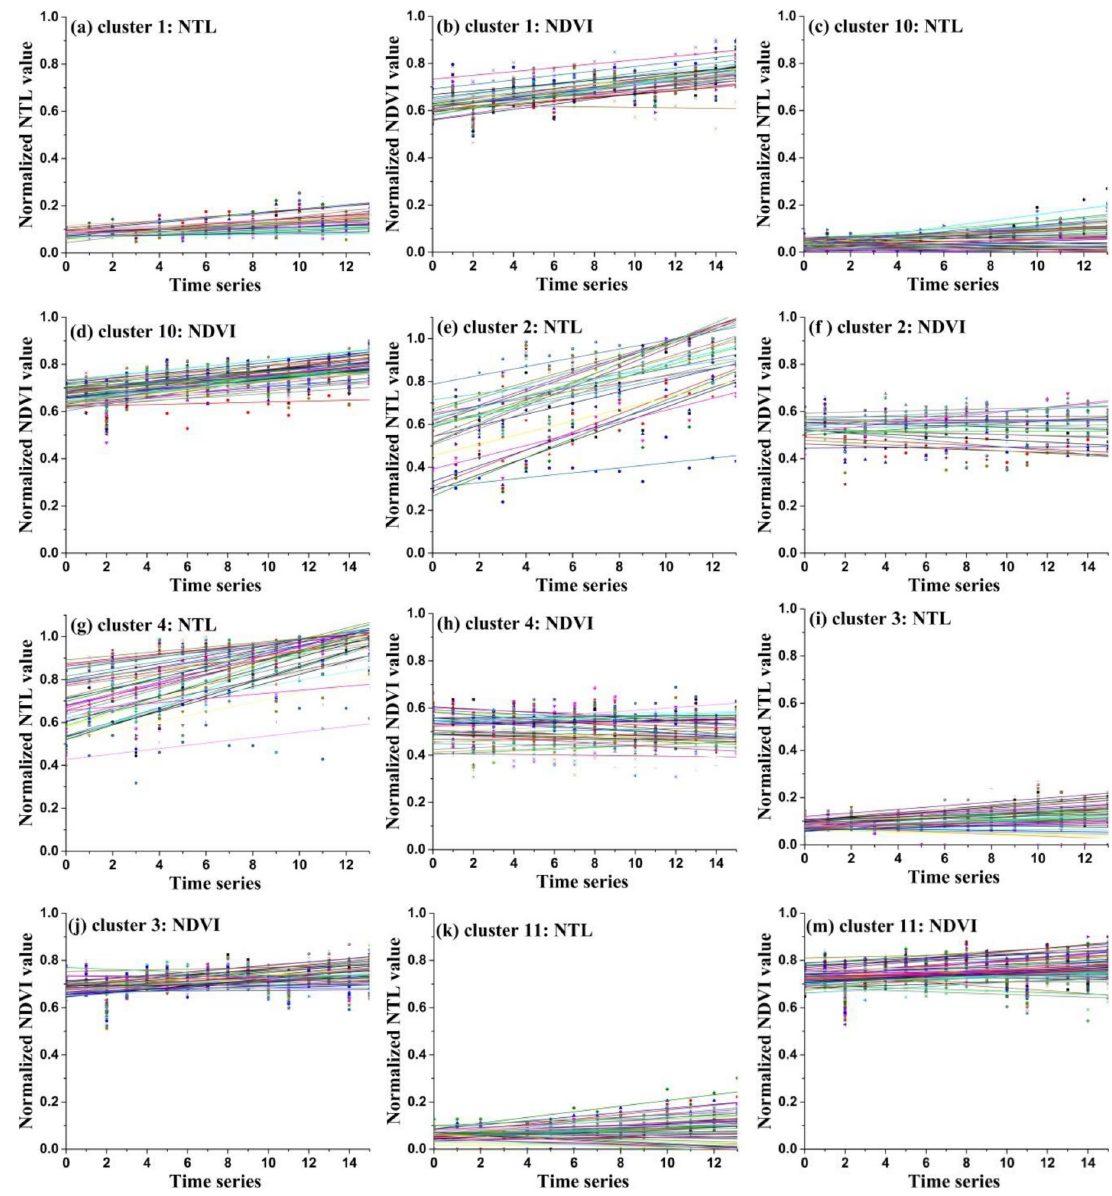
Fig 6. The linear model lines of the samples of cluster 1, cluster 2, cluster 3, cluster 4, cluster 10 and class 11. strict urban expansion restriction scenario. In this scenario, the water bodies, LDSU-VI, and LDSU-HDSV were as in the second scenario. The regions UE-LDSV, UE-HDSV and UE-VD, were set to 80 in the exclusion layer to more strictly limit urban growth. SLEUTH’s three calibration stages, coarse, fine, and final, were applied for each simulation scenario. As shown in Table 2, the optimal coefficients for dispersion, breed, spread, slope, and road gravity were 1, 18, 19, 90, and 75 in scenario 1; 1, 1, 39, 68, and 68 in scenario 2; and 1, 2, 78, 56, and 37 in scenario 3. The average Lee-Salle values of the three calibration processes were 0.707 in scenario 1, 0.709 in scenario 2, and 0.708 in scenario 3. According to previous research, calibration is acceptable when the Lee-Salle values are between 0.3 and 0.7 [24, 60].